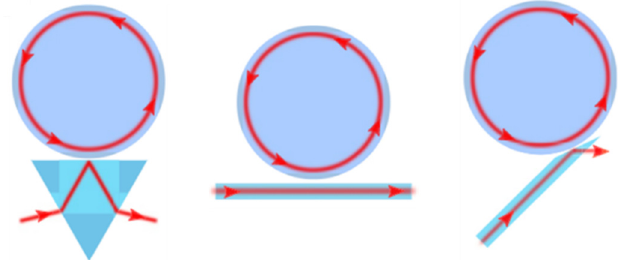
Figure 16. Coupling methods for WGM resonators. Reproduced from ref. [103] with permission from Elsevier.